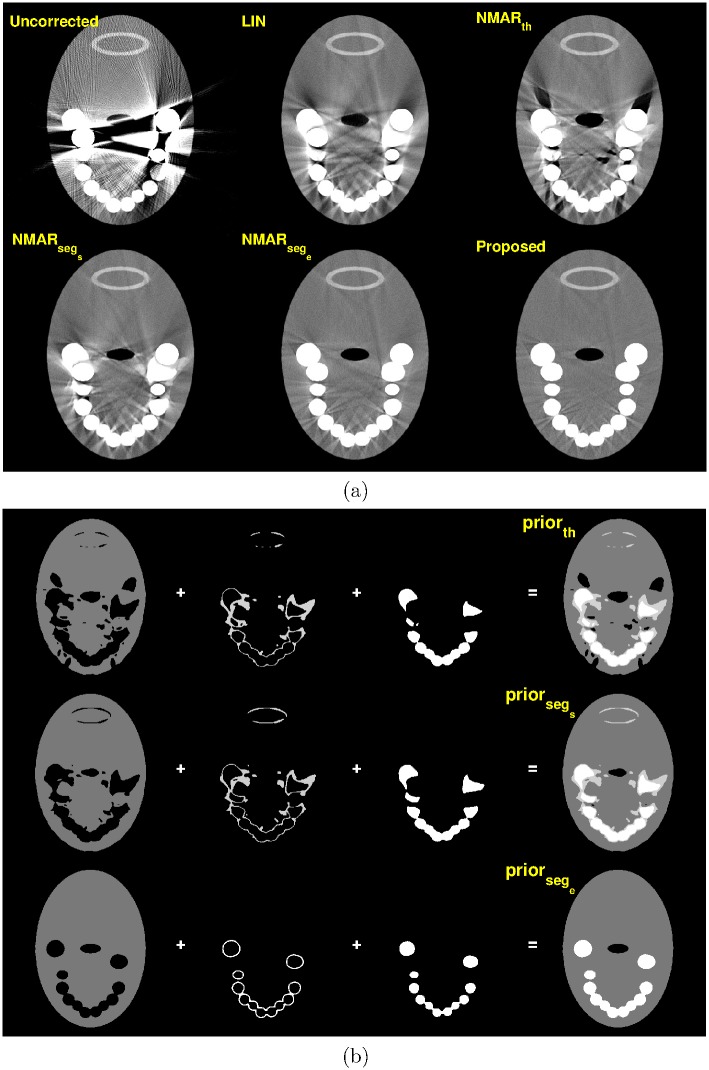
Results of the jaw phantom (C = 250 HU/W = 750 HU).(a) Top row: reconstruction images by (left) Uncorrected, (middle) LIN, and (right) NMARth images. Bottom row: reconstruction images by (left) NMARsegs, (middle) NMARsege, and (right) the proposed MAR. (b) Prior images by (top) simple thresholding, (middle) RAC segmentation of the LIN image, and (bottom) RAC segmentation of the final iteration image.